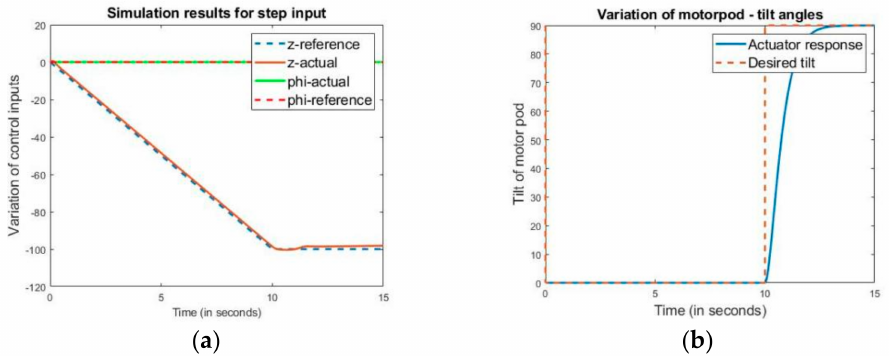
Figure 16. Variation of control parameters in the flight profile. Here, ( a ) shows the variation of the height and pitch angle along with the flight profile, and ( b ) shows the tilt of both the motor pods during the entire flight